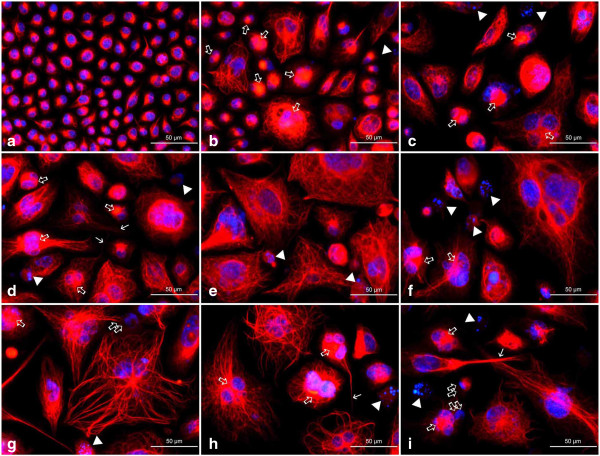
a-i Organization of vimentin in A549 cells after treatment with etoposide - fluorescence microscopic examination (vimentin indirect labeling, secondary antibody was goat anti-mouse IgG-TRITC). a Control cells, b, c 0.75 μM etoposide, d-f 1.5 μM etoposide, g-i 3 μM etoposide. Apart from regularly organized bundles of filaments in the control cells, abundant, but more heterogeneously organized structures appeared as a result of the treatment. Thick arrows point at dense, thick vimentin bundles in the form of septum-like aggregates between sister nuclei, especially common in multinucleated cells, or vimentin threads in the nuclear invaginations; double thick arrows - putative budding-like structures in close proximity of the parental cells; thin arrows - long vimentin tails; arrowheads - diffuse vimentin staining around nuclei with features of karyorrhexis or karyolysis. Nuclei were counterstained with DAPI. Results are indicative of five independent experiments. Bar 50 μm.